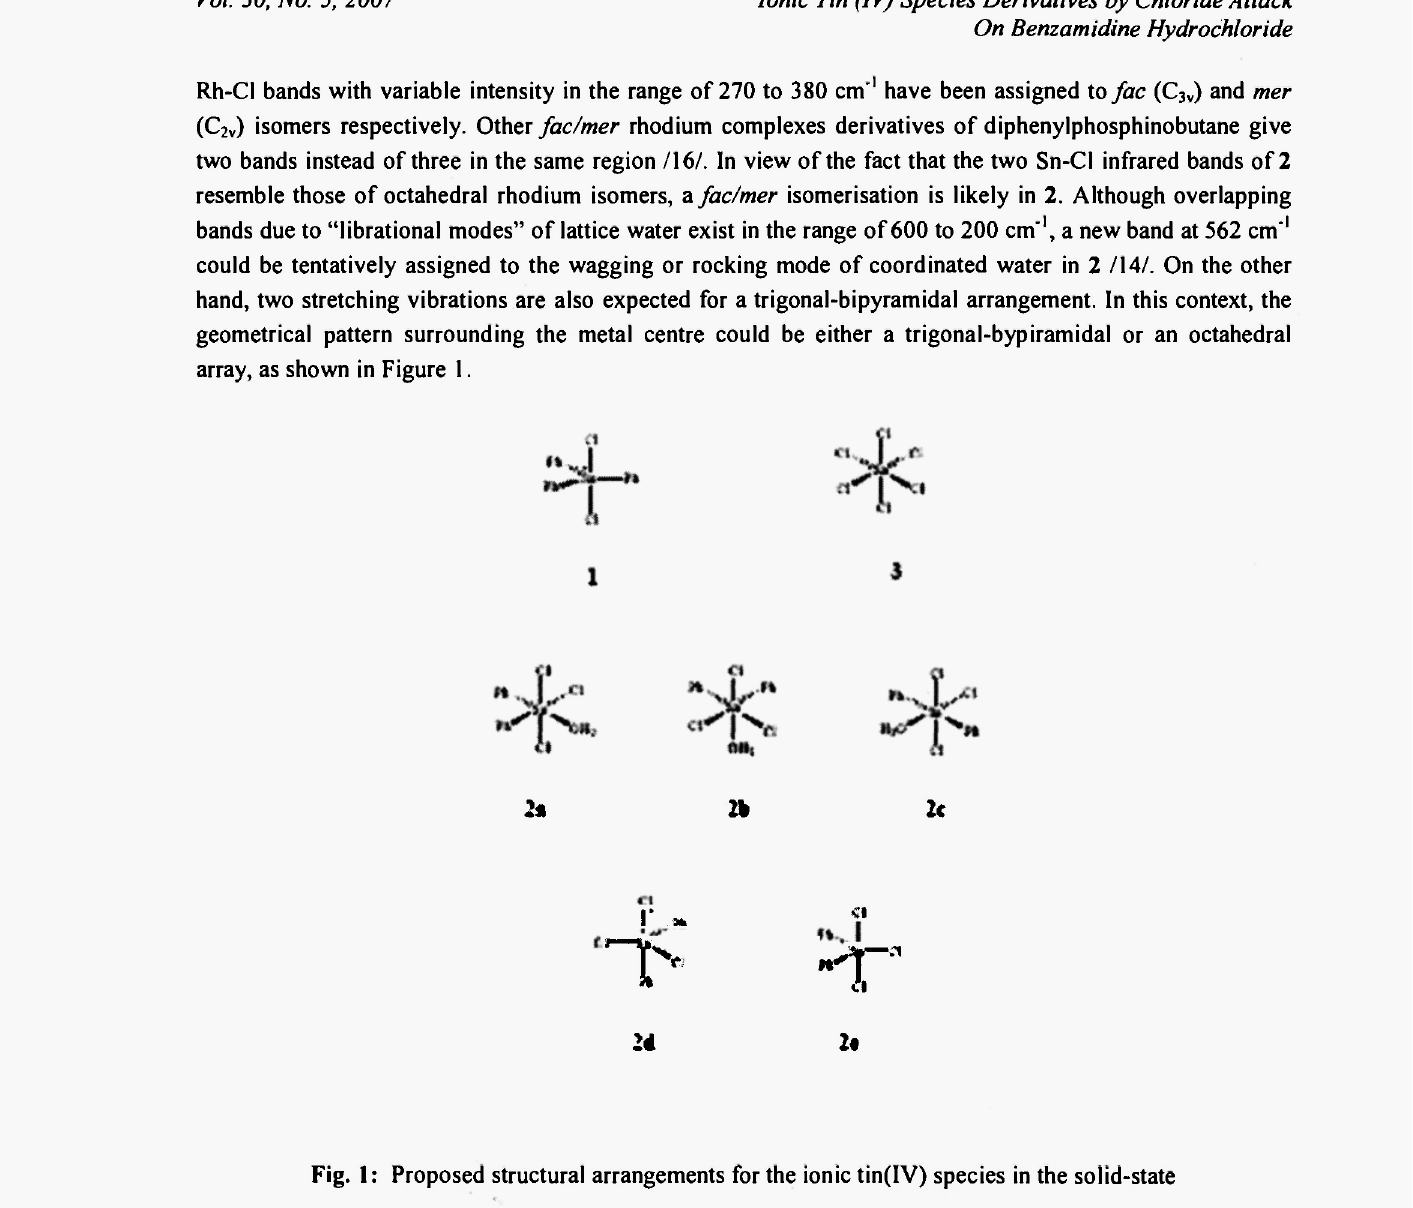
Fig. I: Proposed structural arrangements for the ionic tin(IV) species in the